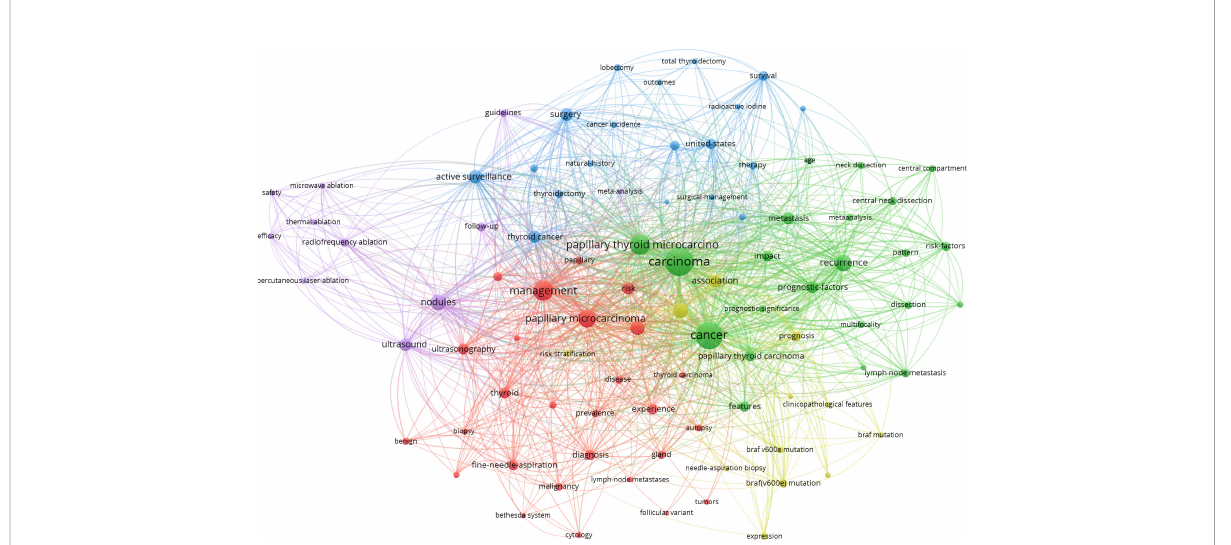
FIGURE 5 Clustering network of terms in PTMC publications from 2000 to 2021. The most common terms used in the scienti fi c literature were investigated to identify relationships among the extracted terms. Dots represent keywords, and the higher the frequency of keywords, the larger the